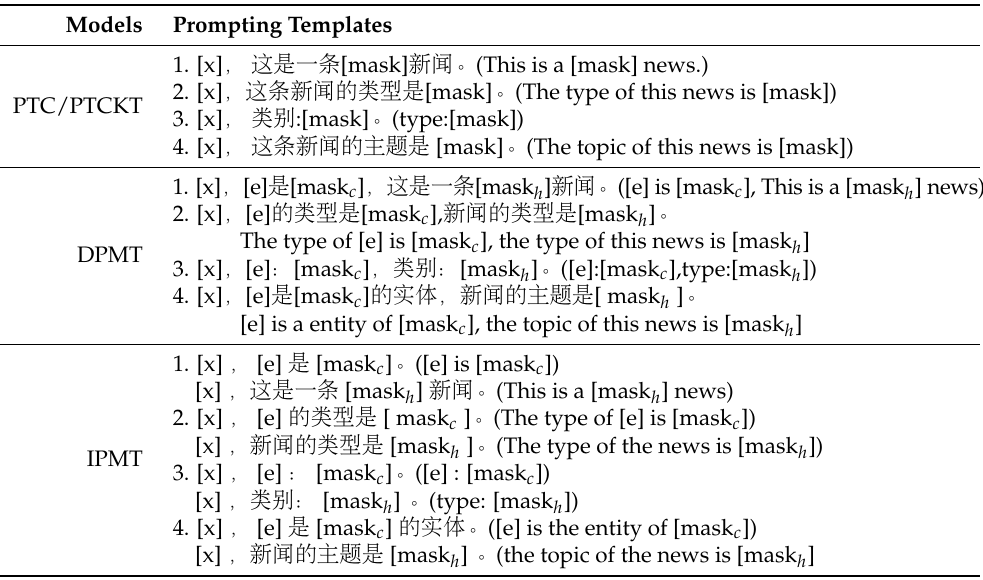
Table 4. Different templates for the prompting models. [x] denotes the headline text; [e] represents the entity in [x]; [mask] refers to the words to be